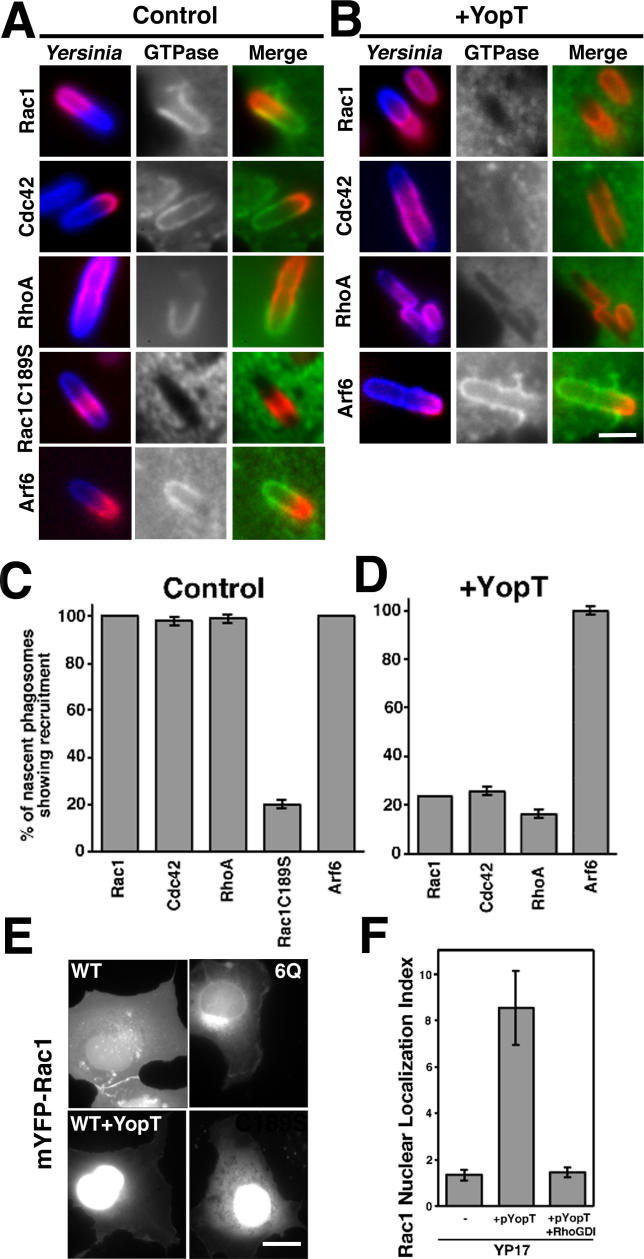

Y. pseudotuberculosis YopT Removes Multiple Rho Family Members from Nascent Phagosomes(A–D) COS1 cells transfected with plasmids encoding T7-Rac1, T7-Rac1C189S, myc-Cdc42, myc-RhoA, or HA-Arf6 were incubated at 37 °C for 30 min with Y. pseudotuberculosis YP17 (A and C) or YP17/pYopT (B and D) grown under described conditions (Materials and Methods). (A and B) To identify nascent phagosomes, bacteria were probed as described (Materials and Methods), and small GTPases were identified by immunoprobing against appropriate tags. Pink identifies the extracellular region of a bacterium and blue represents the internalized region. Green indicates the staining for small GTPases. (C and D) Quantifications of the percentage (mean ± SEM in triplicate) of partially internalized bacteria that stained positively for Rac1 (n = 33), Cdc42 (n = 33), RhoA (n = 33), Rac1C189S (n = 33), or Arf6-HA (n = 11).(E) Representative localization of uninfected cells expressing mYFP-Rac1(WT), mYFP-Rac1C189S, or mYFP-Rac16Q, as well as a mYFP-Rac1(WT) transfectant challenged with YP17/pYopT for 30 min (WT; +YopT). White bar represents 1 μm.(F) The presence of excess RhoGDI interferes with the activity of YopT. Y. pseudotuberculosis YP17/pYopT (+pYopT) was introduced for 30 min onto COS1 cells or transfectants overexpressing RhoGDI. Nuclear localization of Rac1 (defined as the ratio of the mean nuclear Rac1 intensity relative to the mean cytoplasmic Rac1 intensity) was determined in each case.